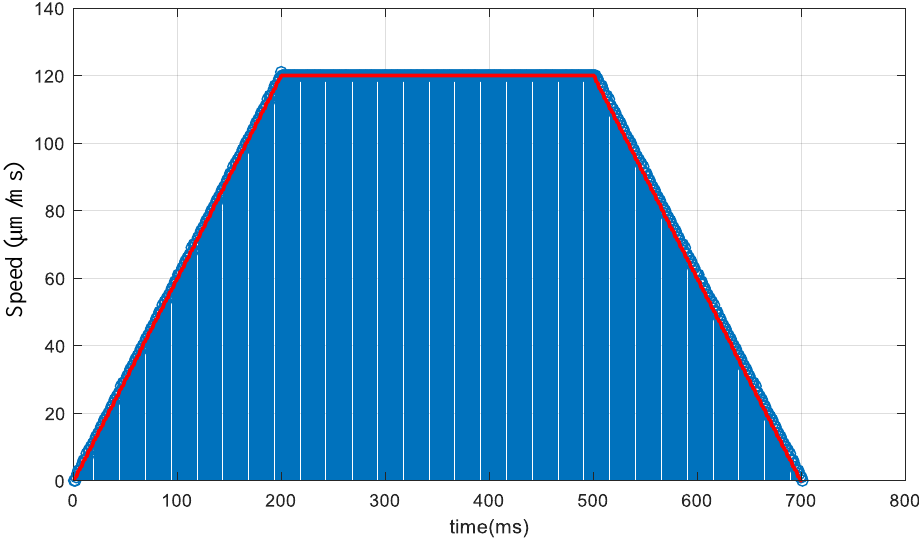
Figure 9. The simulated result for the Trapezoidal speed profile generator.